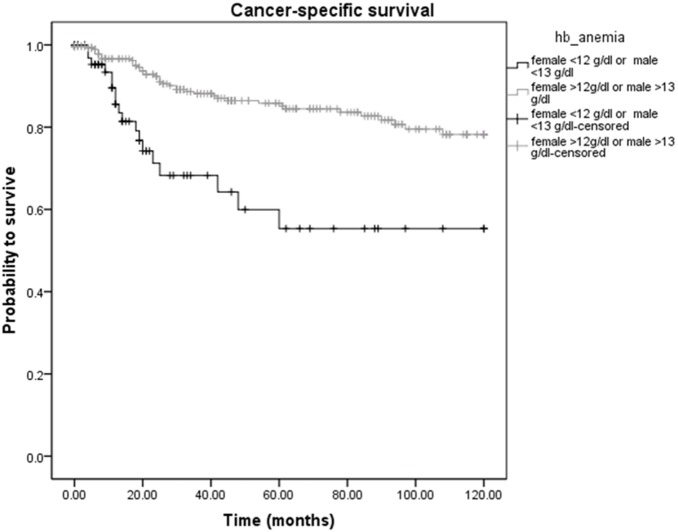
Kaplan-Meier curve for cancer-specific survival regarding high (≥13 g/dl in males and ≥12 g/dl in females) versus low (<13 g/dl in males and <12 g/dl in females) hemoglobin levels (p<0.001).